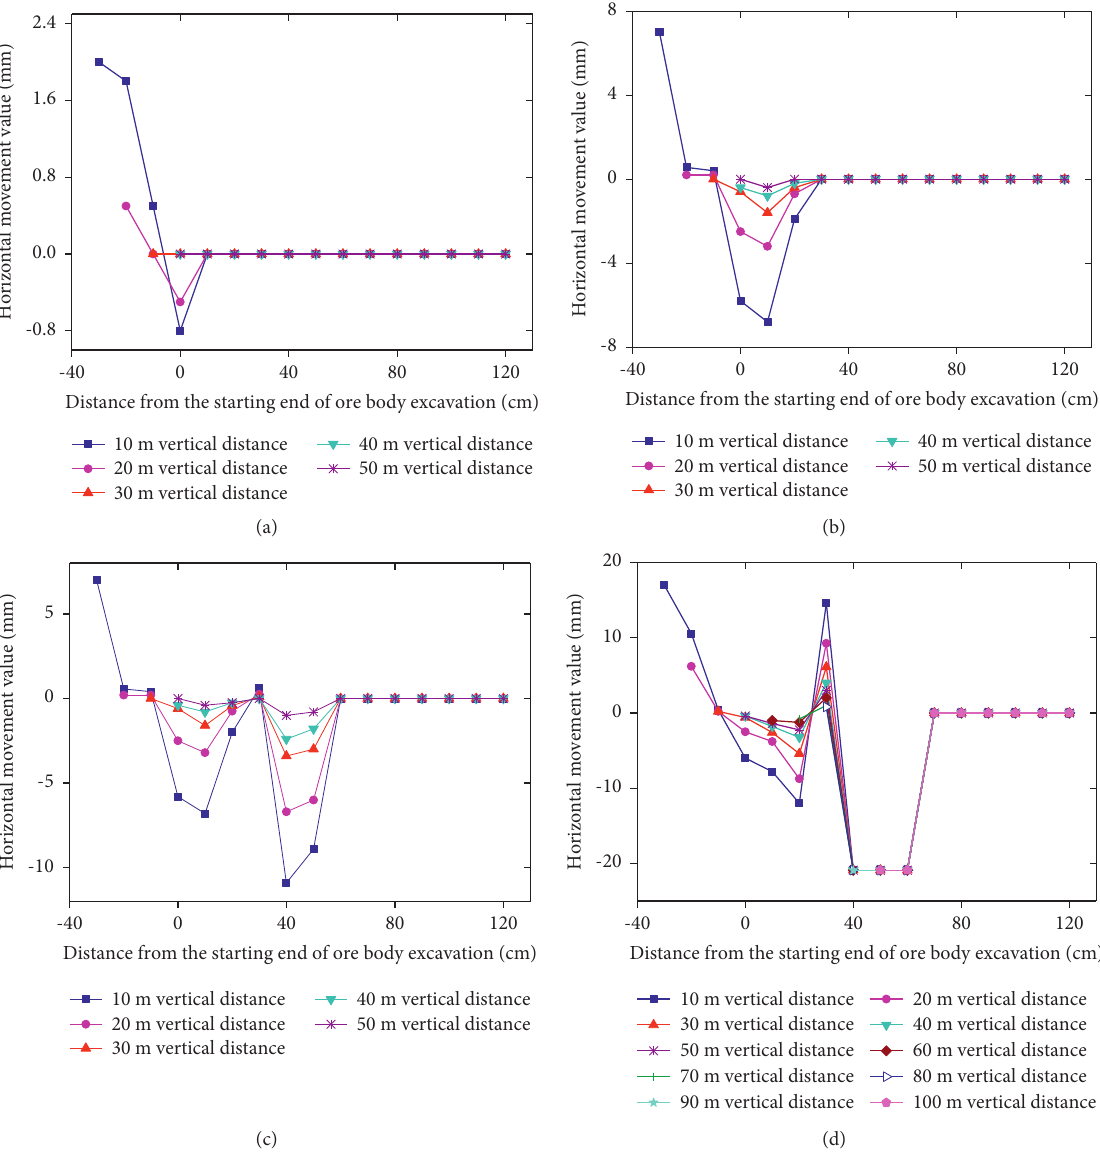
Figure 8: Surveying variation curve of horizontal displacement follows each exploit progress (50 ° ). (a) Change curve of horizontal displacement after 1-step excavation of measuring point. (b) Change curve of horizontal displacement after 5-step excavation of measuring point. (c) Change curve of horizontal displacement after 8-step excavation of measuring point. (d) Change curve of horizontal displacement after 10-step excavation of measuring